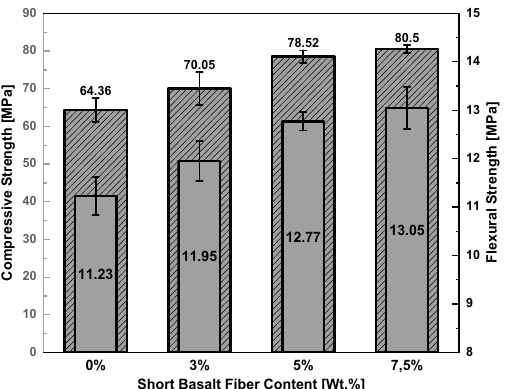
Figure 5. The flexural strength (gray plot) and compressive strength (striped plot) of geopolymer mortar matrix at 28 days. mortar matrix at 28